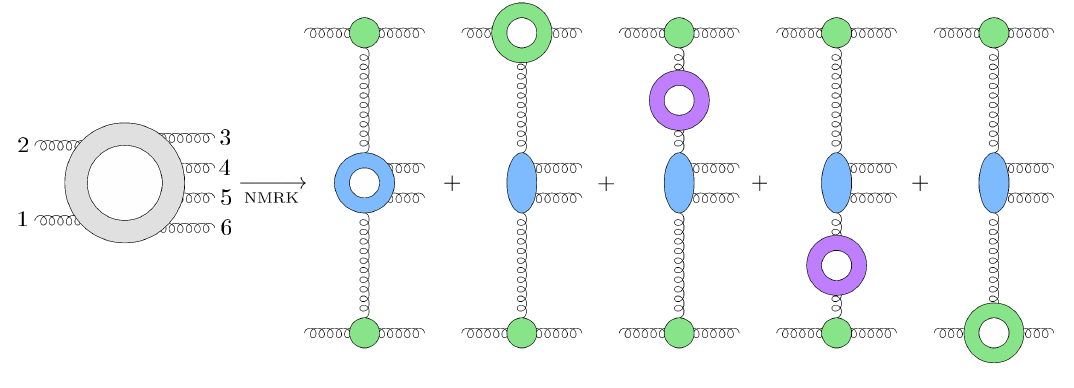
, which we identify as A